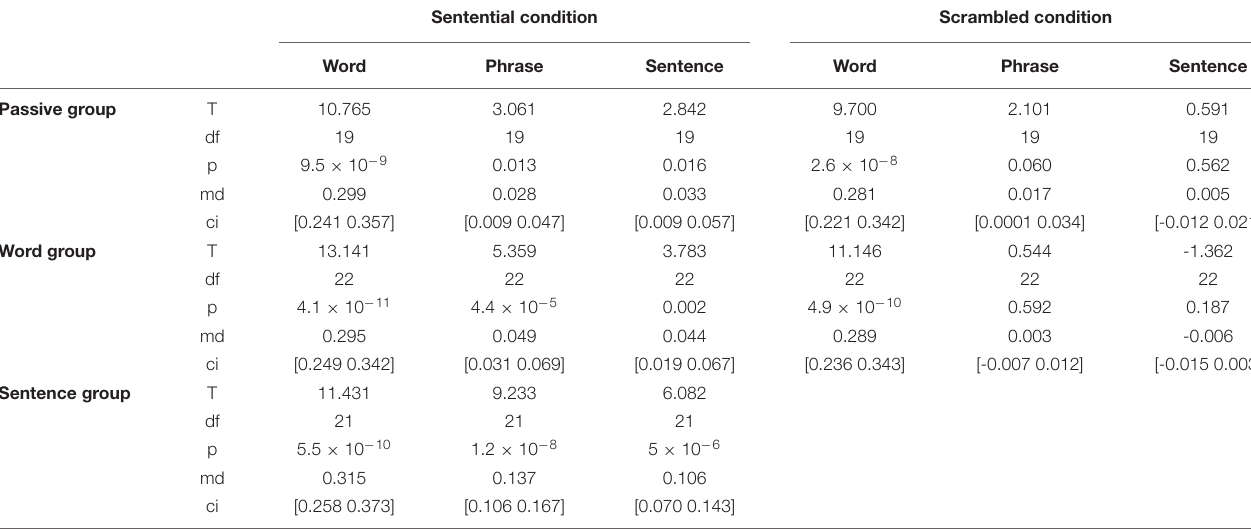
TABLE 1 | Results of paired t -tests quantifying ITPC at target frequencies. Sentential condition Scrambled condition Word Phrase Sentence Word Phrase